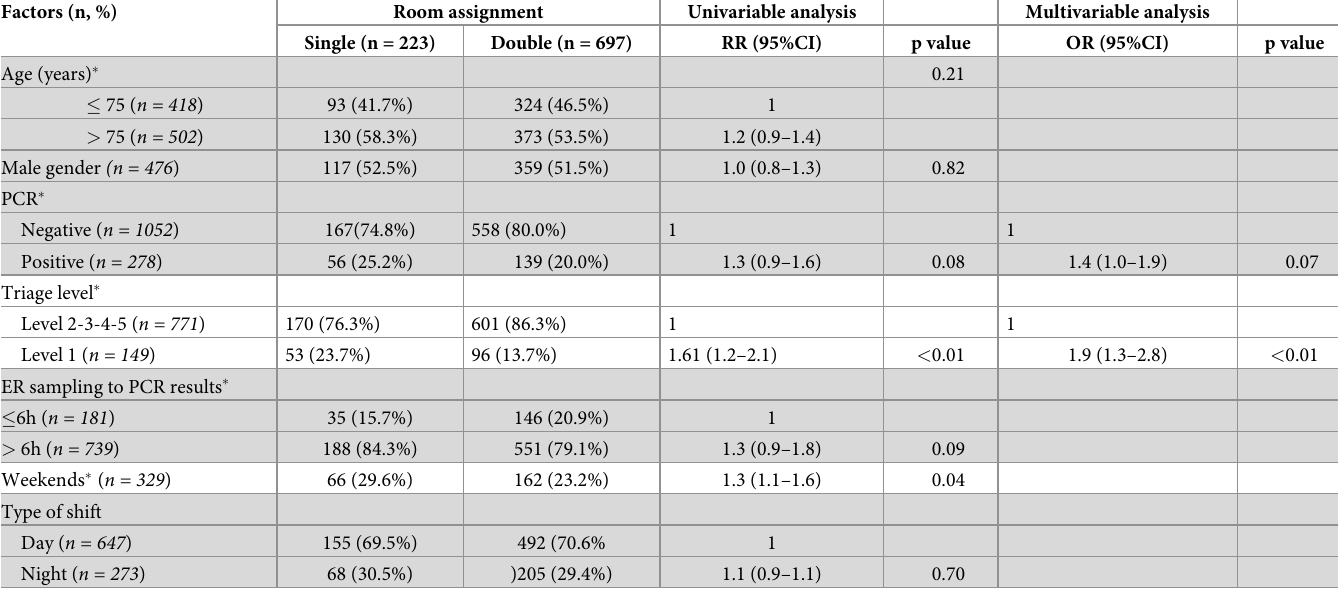
Abbreviations: PCR, Polymerase Chain Reaction. � Included in multivariable